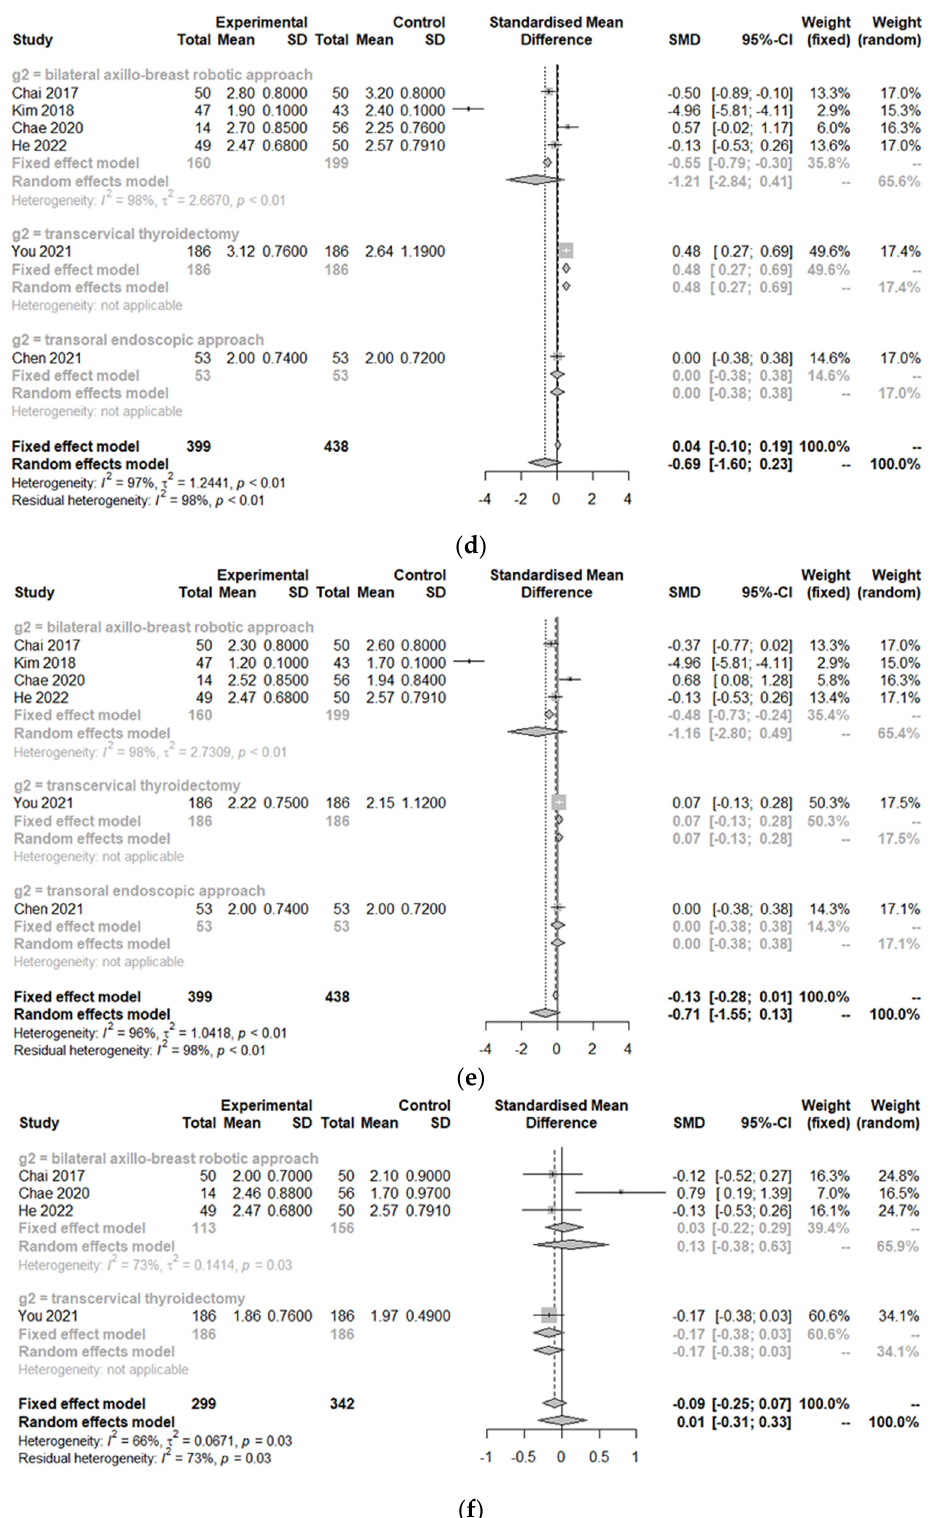
Figure 5. Forest plot for standard mean difference in postoperative outcomes (cosmetic satisfaction ( a ), hospitalization day ( b ), postoperative pain score on the operation day ( c ), postoperative day 1 ( d ), day 2 ( e ), day 3 ( f )) (total: number of participants per group).